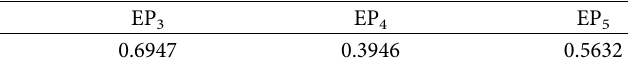
Table 11: IVIFPIS ( ξ